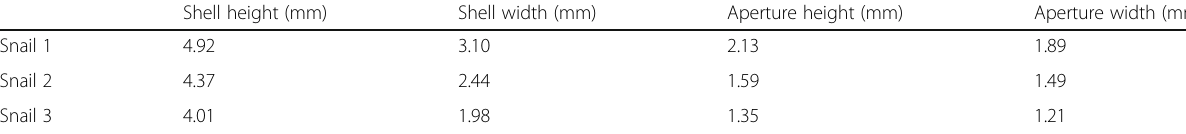
Table 1 Shell measurements of the original snails used in the computational fluid dynamics simulations